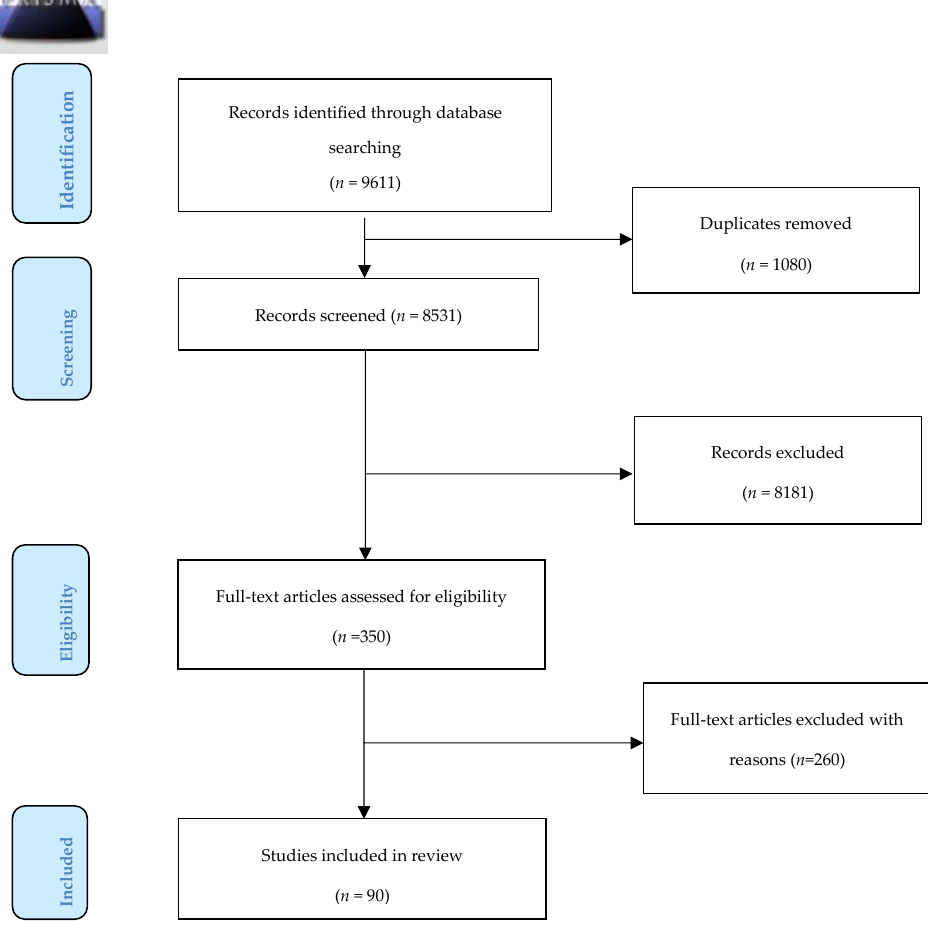
Figure 1. Preferred Reporting Items for Systematic Review and Meta-Analyses (PRISMA) diagram.